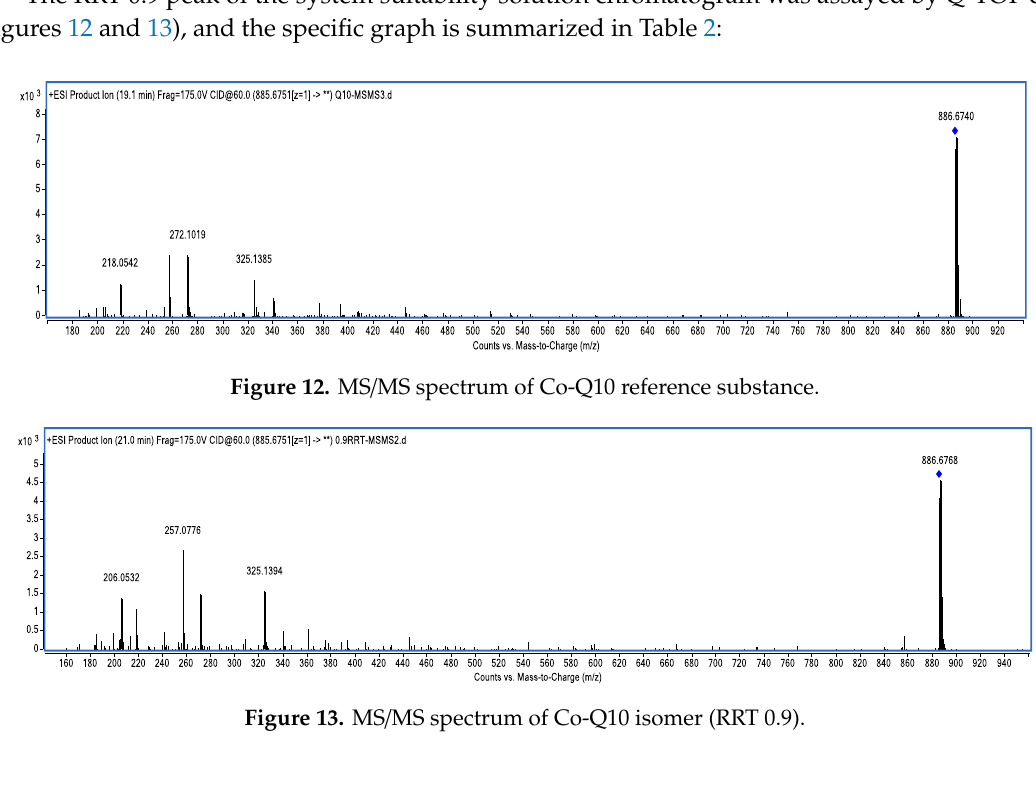
Figure 11. The system suitability spectrum obtained by adding 30% hydrogen peroxide solution at 2 μL for different time periods ( a 4 h; b 24 h).